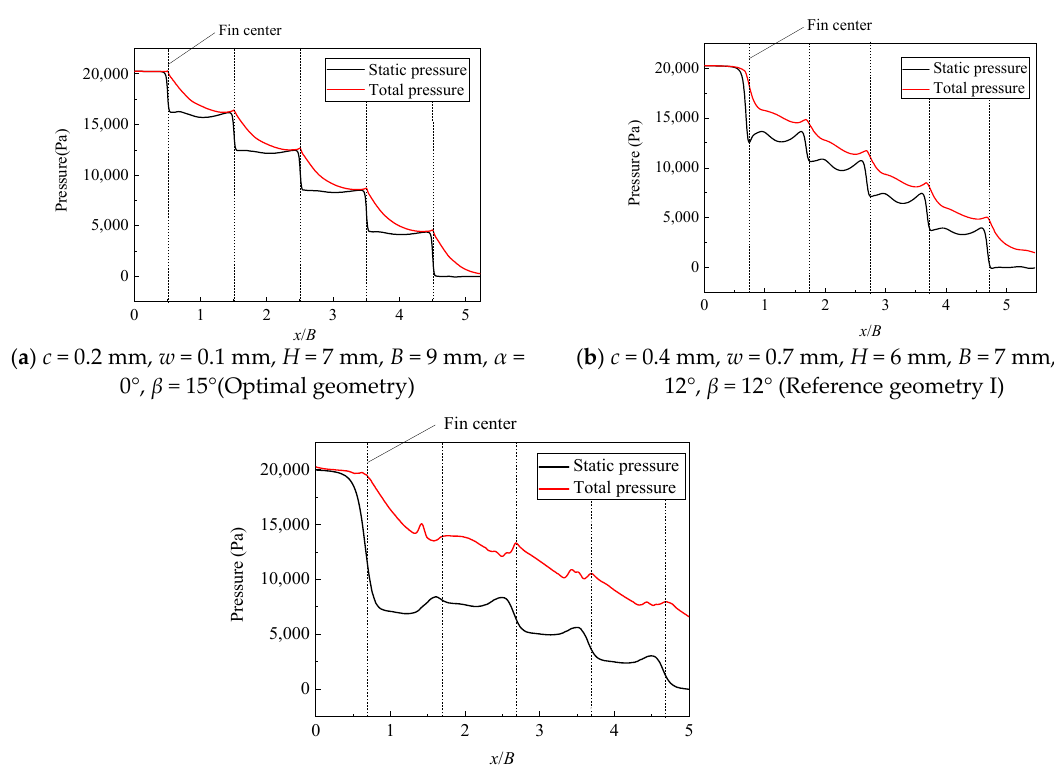
Figure 9. Distribution of gas velocity in the second seal cavity (Unit: m/s).